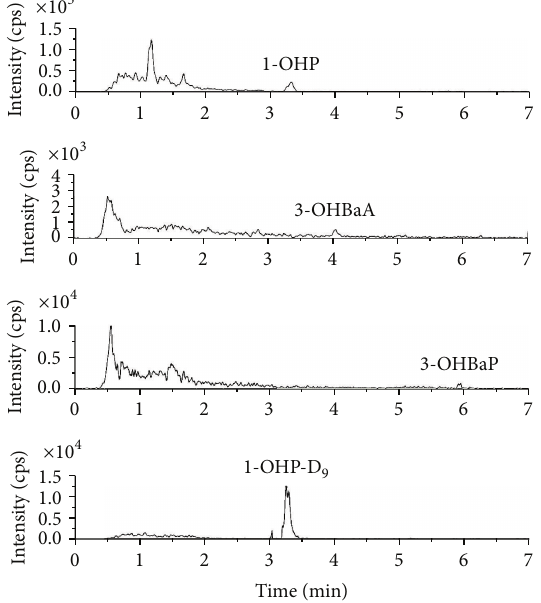
Figure 1: Representative chromatogram from a